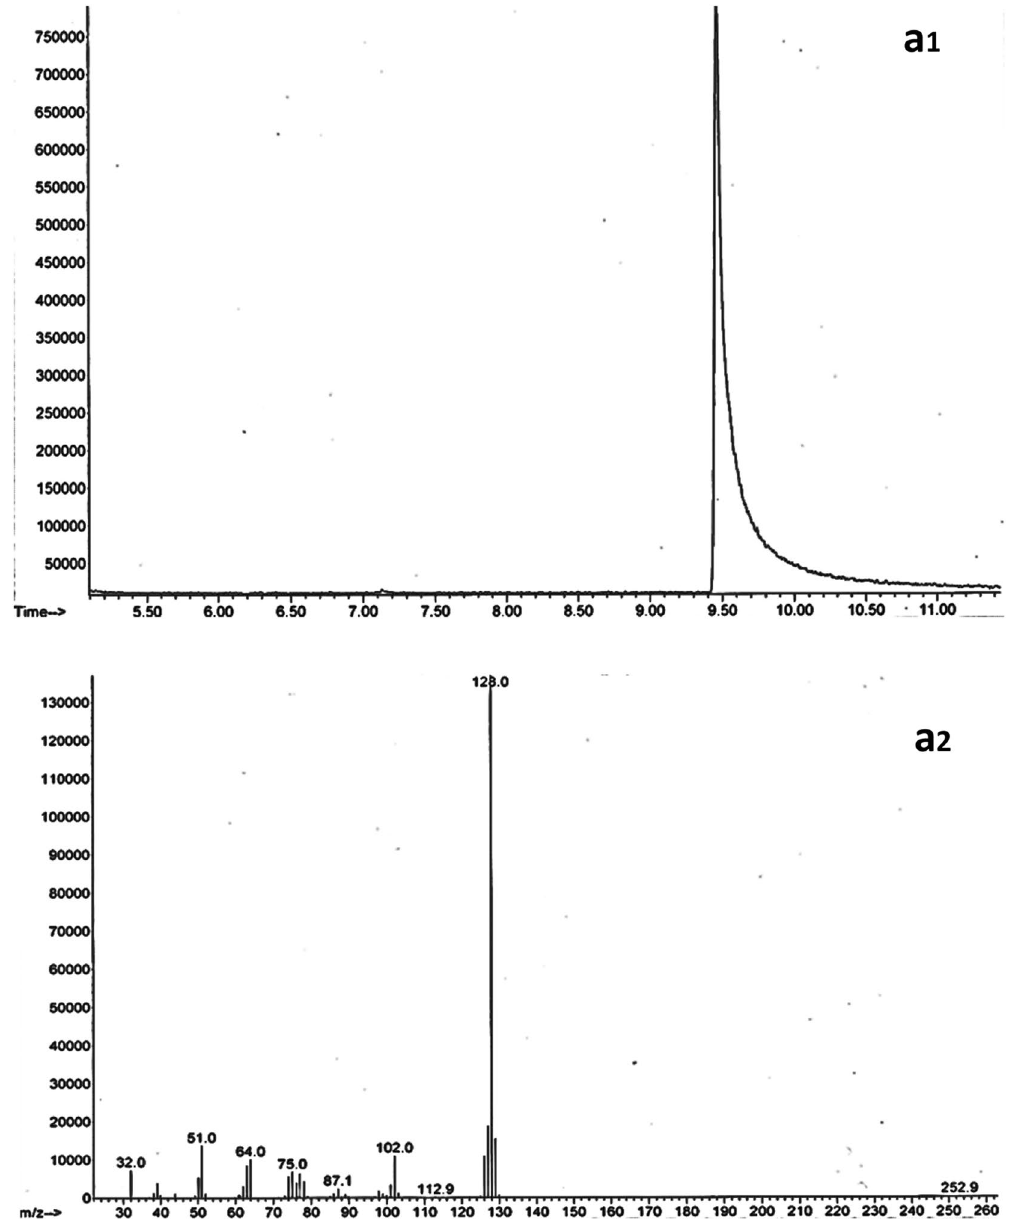
Figure 2. GC Chromatogram ( a1 ) and mass spectra ( a2 ) of